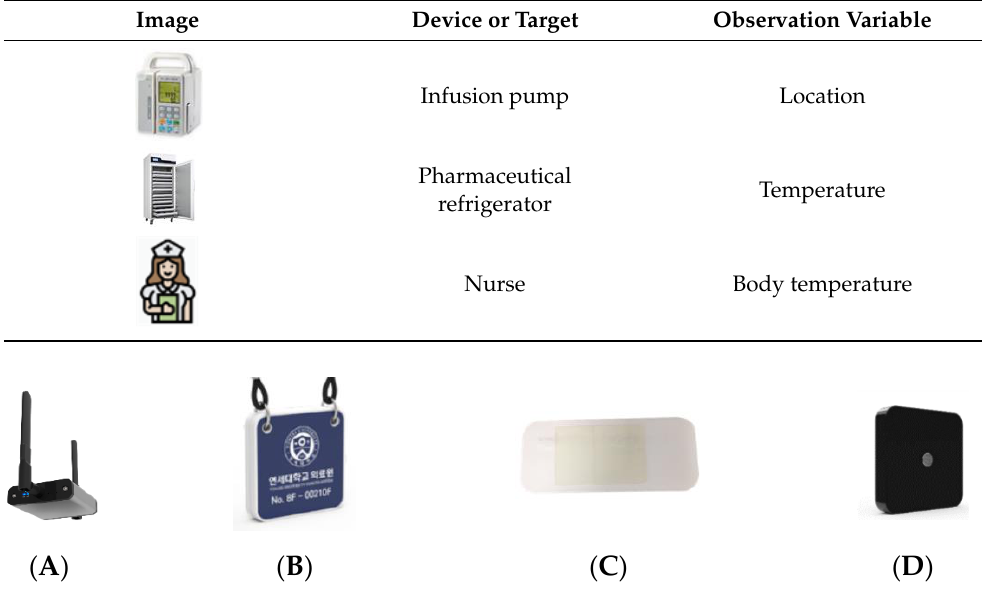
Figure 4. Practically Applied Devices ( A ) WiFi; ( B ) Location sensor (Yonsei University Health System Badge); ( C ) Patch type temperature sensor; ( D ) Environmental thermometer.